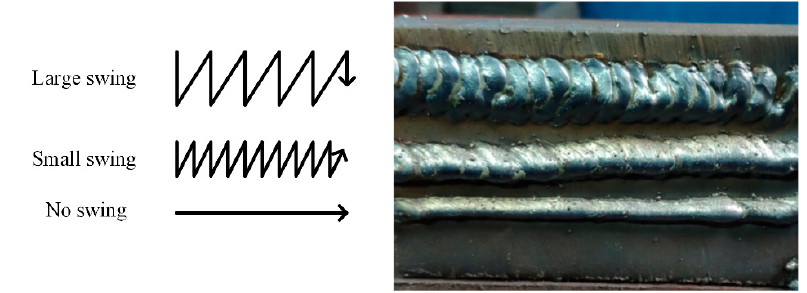
Figure 10. Effect of swing on welding bead formation.